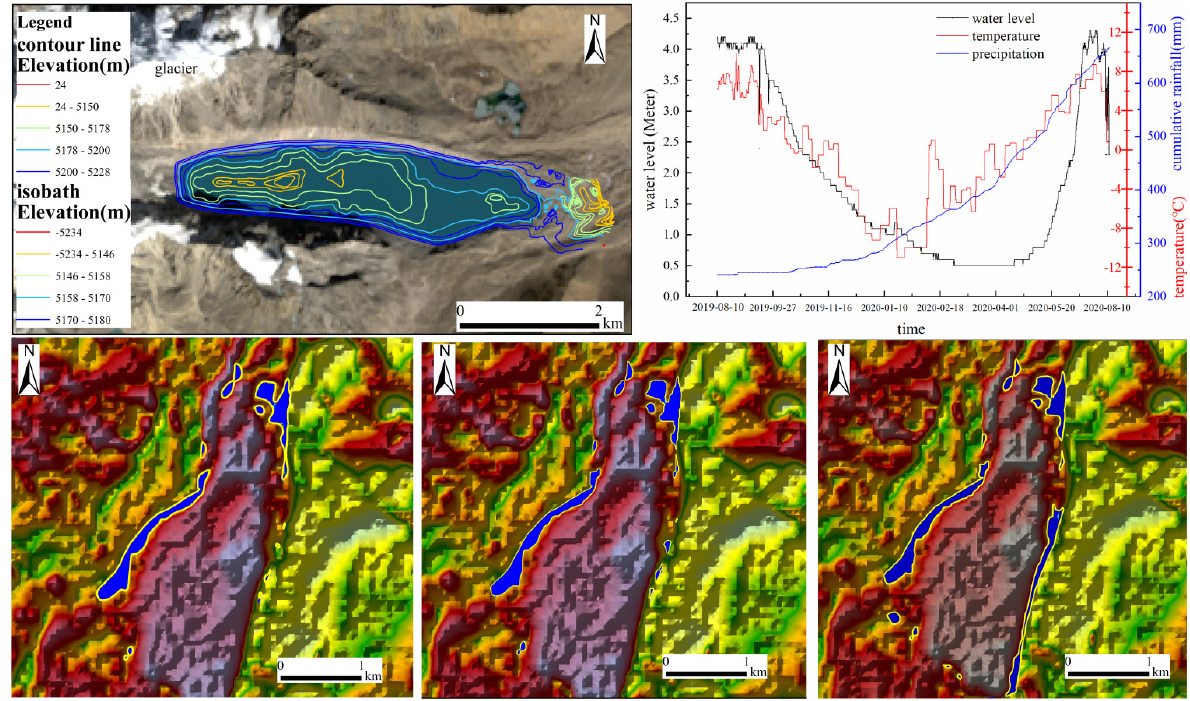
Figure 12. Changes before and after the glacial lake